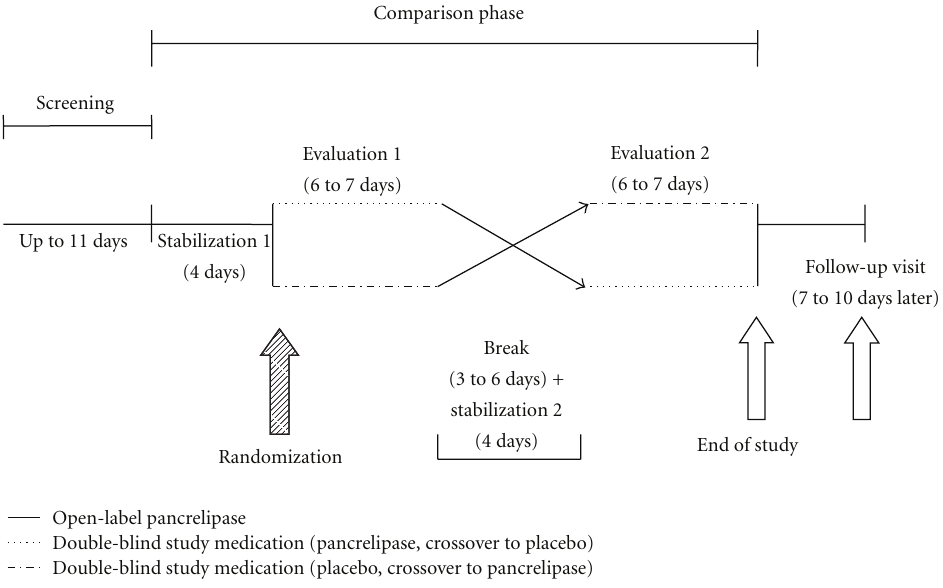
Figure 1: Schema of study design with a screening phase followed by a randomized crossover comparison phase that included 2 stabilization periods, a break period and 2 evaluation